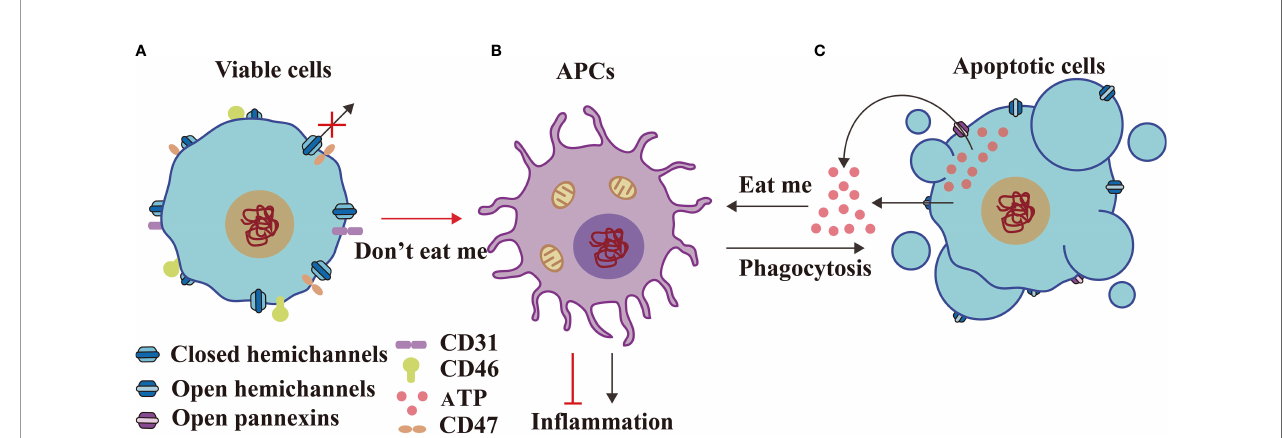
FIGURE 3 | HCs and IGLDCPs display dual functions in innate immunity. Viable cells form closed HCs (A) with APCs (B) transmitting “ don ’ t eat me ” signals, including CD31, CD47, and CD46, to suppress in fl ammation. In contrast, apoptotic cells (C) send an “ eat me ” signal to APCs by opening the HCs and releasing ATP, which engulfs apoptotic cells and causes in fl ammation (56). HC, hemichannel; IGLDCP, Ig-like domain-containing protein; APC, antigen-presenting